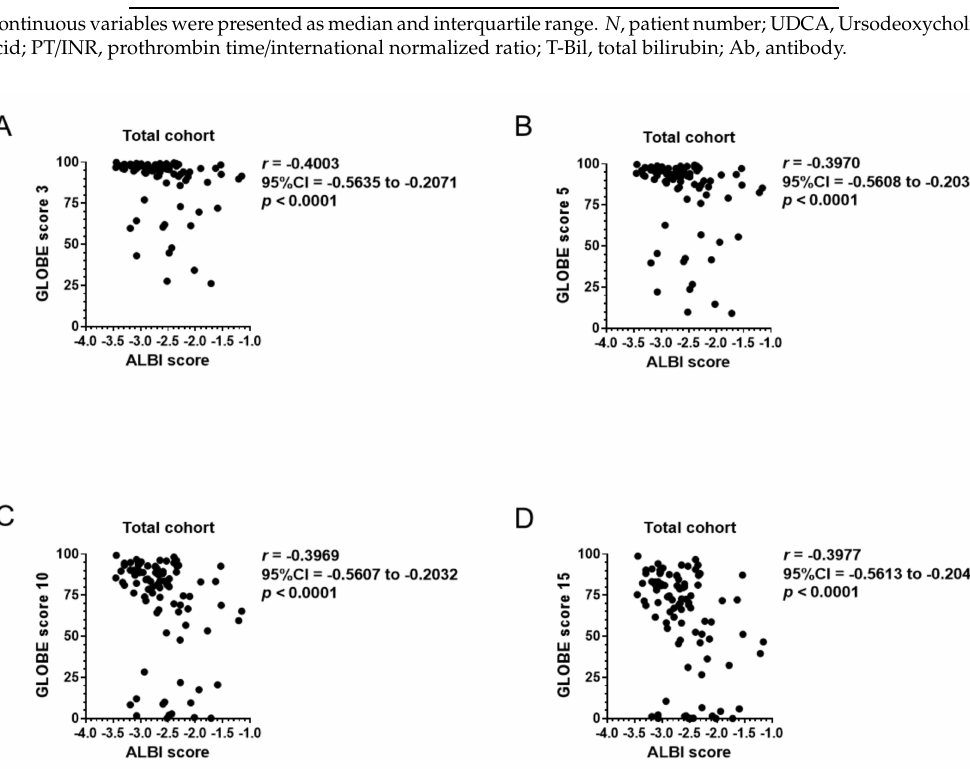
Figure 3. Correlation of the baseline ALBI score with the GLOBE score. ( A – D ) In 93 patients with available blood exam data one year after UDCA therapy, the ALBI score at the beginning of UDCA treatment significantly correlated with GLOBE scores 3, 5, 10 and 15. ALBI, albumin–bilirubin; CI, confidence interval; T-Bil, total bilirubin; Alb, albumin; Plt, platelet count; UDCA, ursodeoxycholic